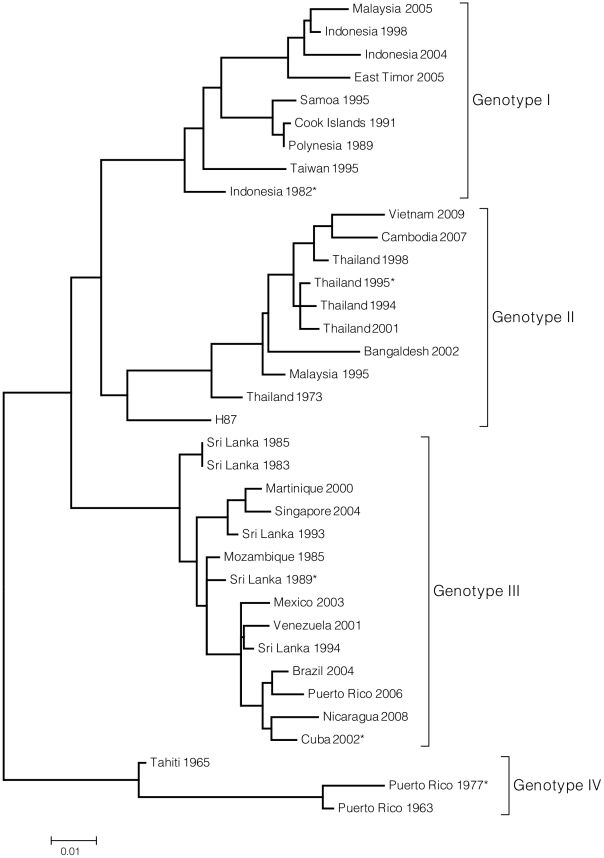
Phylogenetic relationship of DENV-3 viruses.The phylogenetic tree illustrates genetic relatedness of DENV-3 virus genotypes, including those viruses from which representative E genes were synthesized. This tree is meant to display DENV-3 diversity but does not include all 175 sequences used to evaluate the genetic variability of the DENV-3 E gene. Instead, representative sequences from each genotype were selected for inclusion in the tree. The tree was constructed using Maximum Likelihood method based on the Tamura-Nei model [66]. The tree is drawn to scale, with branch lengths measured in the number of substitutions per site. The analysis involved 37 nucleotide sequences. There were a total of 1479 positions in the final dataset. Evolutionary analyses were conducted in MEGA4 [67]. *Parent virus for E gene variants.